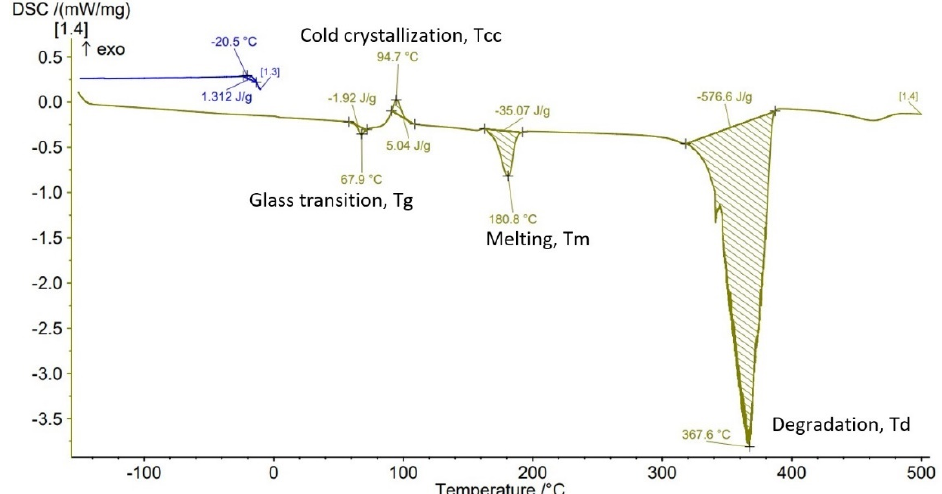
Figure 11. DSC thermogram related to sample with 100% infill density.